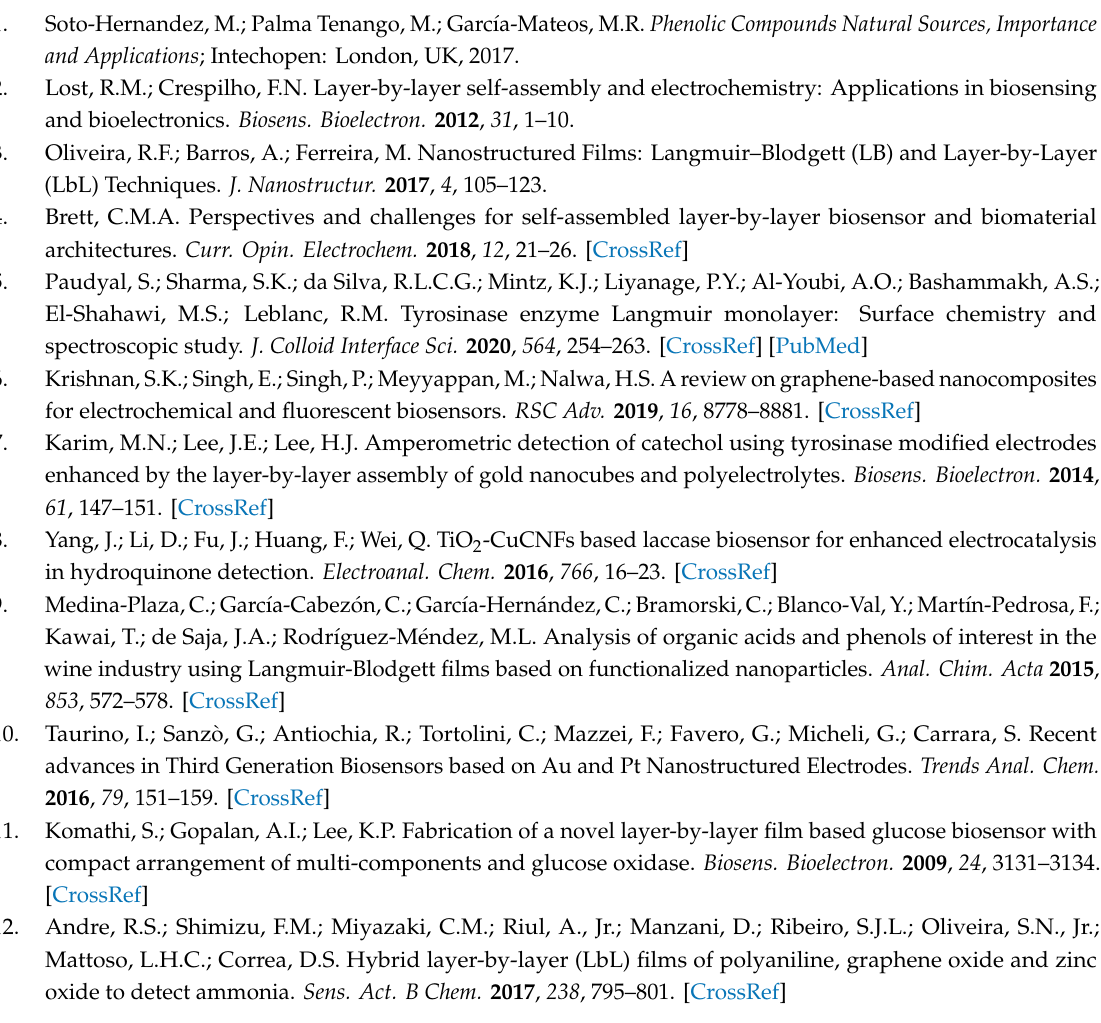
Figure S1: Materials used to form the sensing platforms: a) gold nanoparticles (AuNPs) capped with citrate; b) sulfonated copper phthalocyanine (CuPcS); and c) chitosan (CHI), Figure S2: UV-Vis spectrum of AuNP solution, Figure S3: UV-Vis spectra of a) [(CHI)-(AuNPs)-(CHI)-(CuPcS)] 2 LbL films with increasing number of layers (n = 4,8,12,16,20); and b) correlation between the absorbance measured at 615 nm and the number of layers, Figure S4: Comparison of the FTIR spectra of the LbL platform [(CHI)-(AuNPs)-(CHI)-(CuPcS)] 2 (solid line) and of the biosensor [(CHI)-(AuNPs)-(CHI)-(CuPcS)] 2 -Lac (dotted line), Figure S5: a) FTIR spectra of the platform [(CHI)-(AuNPs)-(CHI)-(CuPcS)] 2 with increasing number of layers (n = 4,8,12,16,20,24) and b) correlation between the transmittance measured at 1033 cm − 1 and the number of layers, Figure S6: CV curves registered in catechol 10 − 4 mol · L − 1 in 0.01 M phosphate bu ff er pH 7 at a bare ITO electrode, Figure S7: CV registered in catechol 10 − 4 mol · L − 1 in 0.01 M phosphate bu ff er pH 7 at [(CHI)-(AuNPs)-(CHI)-(CuPcS)] 2 -Lac electrode, where the enzyme was cross-linked by immersion in glutaraldehyde liquid (dotted line) and exposure to glutaraldehyde vapors (solid